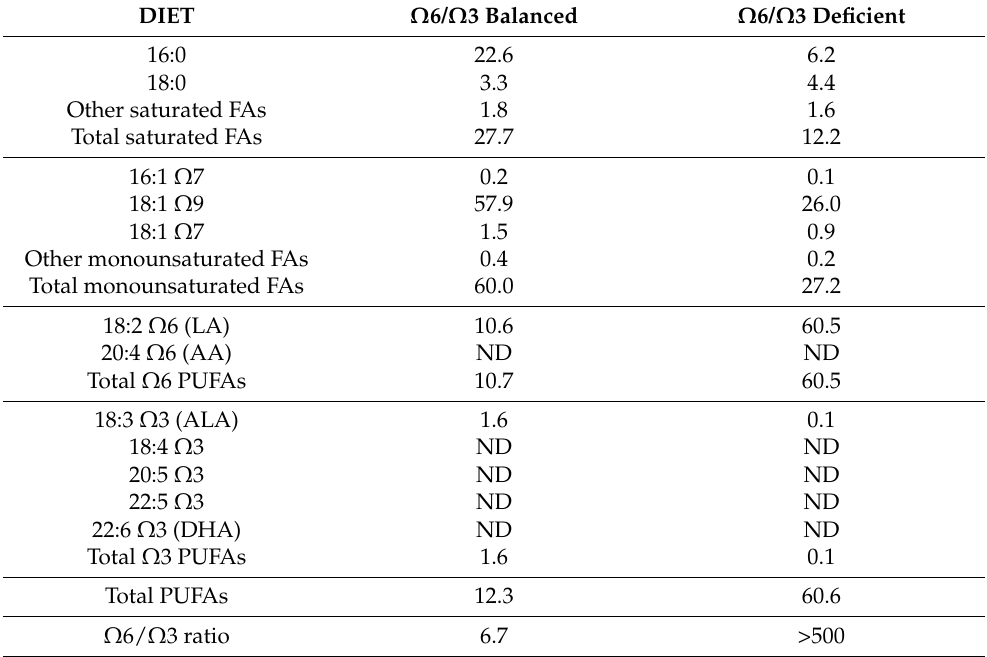
Table 2. Fatty-acid composition of the dietary lipids (percentage of weight of total fatty acids). FAs: fatty acids; LA, linoleic acid; AA, arachidonic acid; PUFAs, polyunsaturated fatty acids; ALA, α -linoleic acid; ND, not detected by gas